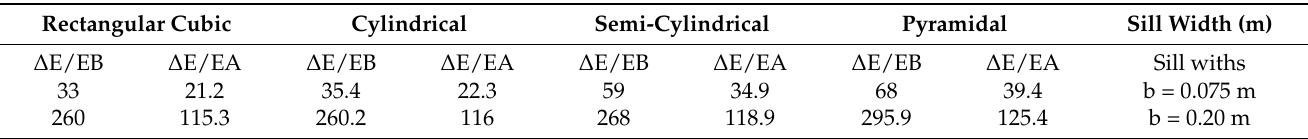
Figure 10. Energy loss values for the ( a–d ) upstream and ( e–h ) downstream sections of the jump with sill. Table 3. Percentage increase in energy consumption of the sluice gate with a sill in sections A and B compared to non-sill state.